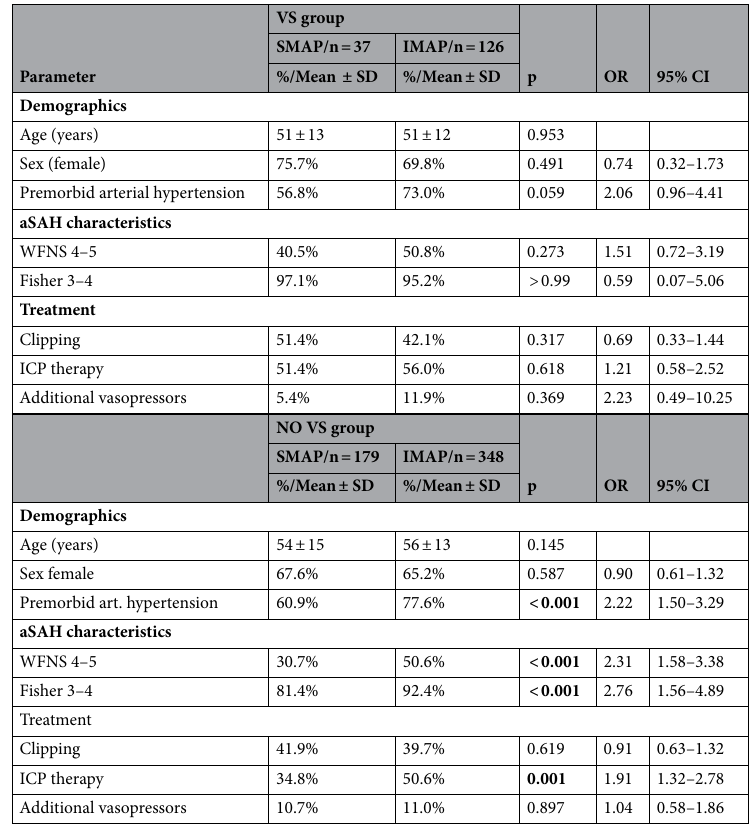
Table 1. Univariate analysis for baseline characteristics of the patients with SMAP/IMAP in the VS and NO VS groups. Significant p-values are marked bold. 95% CI 95% confidence interval, ACS acute coronary syndrome, aSAH aneurysmal subarachnoid hemorrhage, ICP intracranial pressure, (I/S)MAP (increased/ standard) mean arterial pressure, OR odds ratio, SD standard deviation, (NO) VS (no) vasospasm, WFNS World Federation of Neurosurgical Societies .